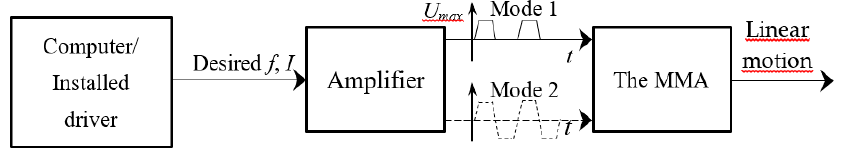
Figure 8. Open loop control . Figure 7. Voltage control scheme. ( a ) Single pulse; and ( b ) double pulse. T1: Rising stage; T2: Opening stage; T3: Falling stage; T4: Dispensing stage.